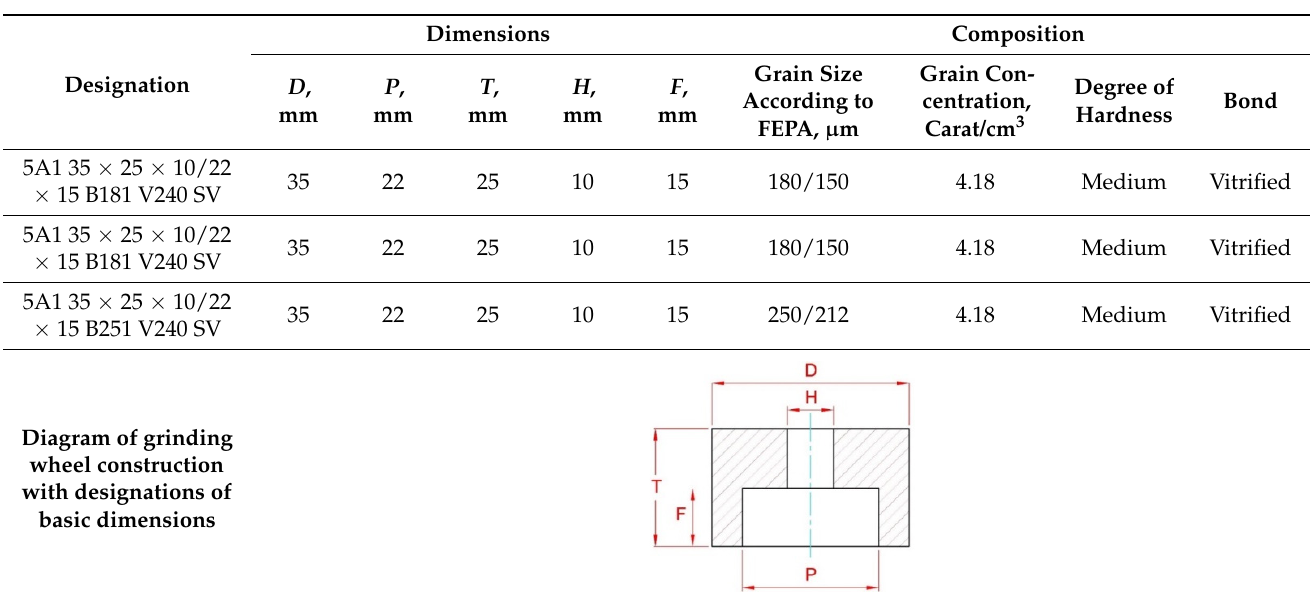
Figure 1. General view of the five-axis CNC special grinder for sharpening technical blades ( a ), view of workpiece clamping fixture ( b ), general view ( c ) and geometric dimensions of the axial outline ( d ) of the planar technical blade (workpiece) as well as view of a special device for removing rewind from blade after grinding ( e ). Table 2. Designation and main technical parameters of the grinding wheels [17].